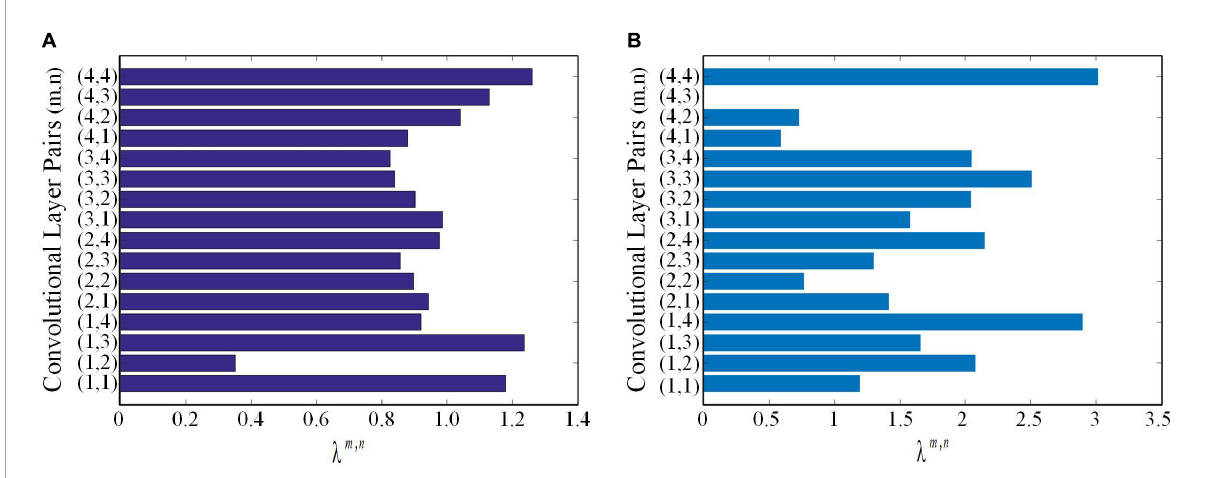
FIGURE8 The matching weights λ m , n of convolutional layer pairs. (A) The matching weights λ m , n of convolutional layer pairs of the source network based on ImageNet. (B) The matching weights λ m , n of convolutional layer pairs of the source network based on lung